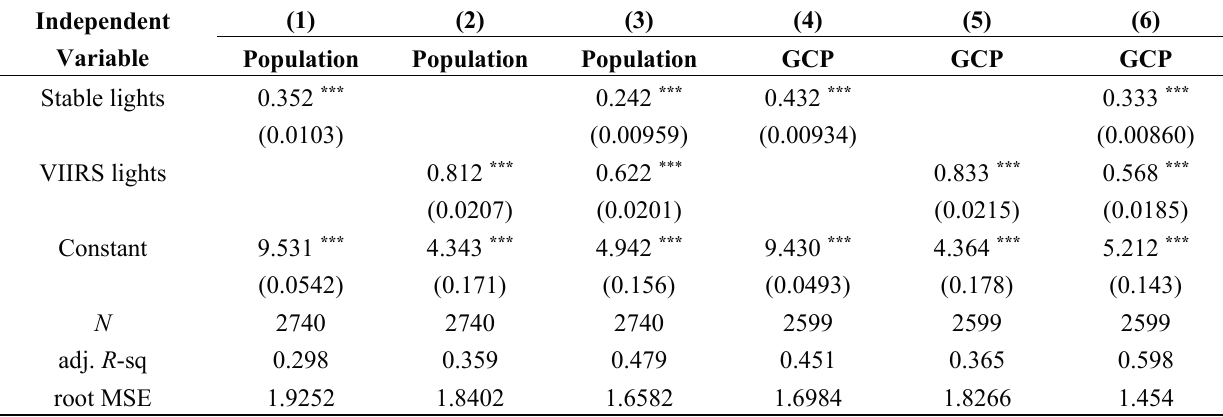
Table 10. Operational Linescan System (OLS) regression for all cells ( ** p < 0.01; *** p <